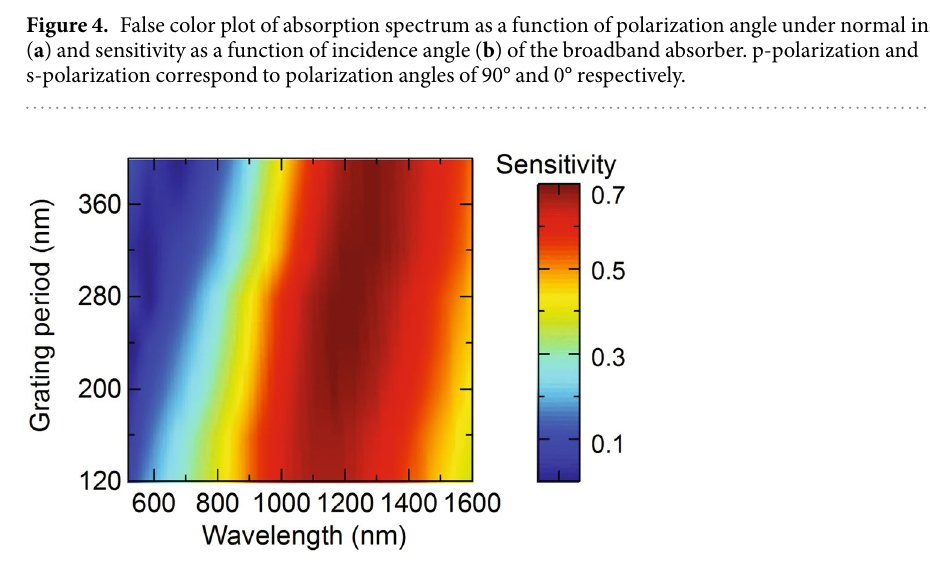
Figure 5. Polarization sensitivity of the broadband absorber as a function of grating period.